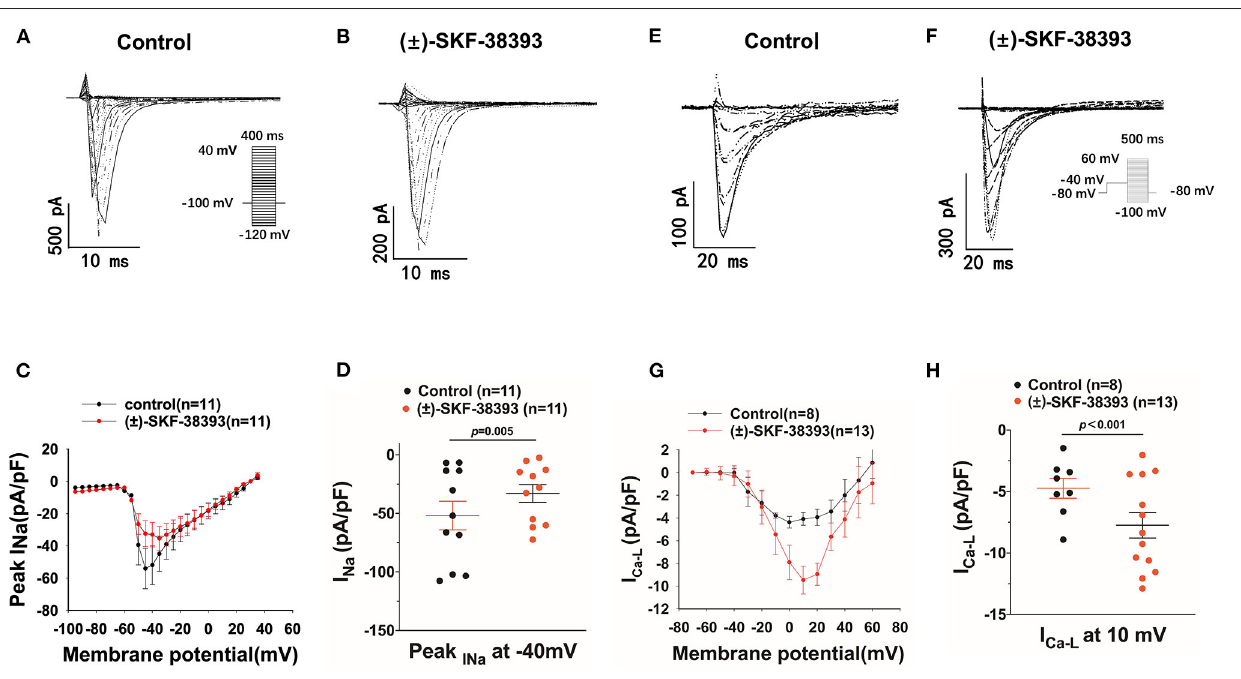
FIGURE 7 | Effects of ( ± )-SKF 38393 or fenoldopam on ion channel currents. hiPSC-CMs were challenged for 1h by vehicle (Control) or 50 µ M ( ± )-SKF 38393 and 5 µ M fenoldopam. Sodium channel current (I Na ) was recorded with the patch clamp (voltage-clamp) protocol indicated in (A) (inset). The L-type calcium channel current (I Ca − L ) was recorded with the voltage-clamp protocol indicated in (F) (inset). (A,B) Representative traces of I Na in absence (Control) and presence of ( ± )-SKF38393. (C) I–V curves of peak I Na . (D) Mean values of peak I Na at − 40mV. (E,F) Examples of traces of I Ca − L in absence (Control) and presence of ( ± )-SKF38393. (G) I–V curves of I Ca − L . (H) Mean values of I Ca − L at 10mV. “ n ” numbers represent the number of analyzed cells. The p -values vs. Control were determined by t